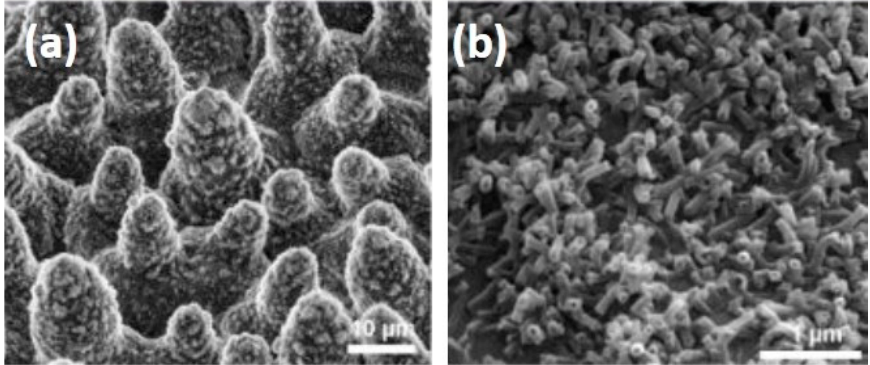
Figure 7. ( a ) Lower and ( b ) higher magnification SEM image of lotus leaf showing the hierarchical surface structure consisting of papillae, wax clusters, and wax tubules [45].